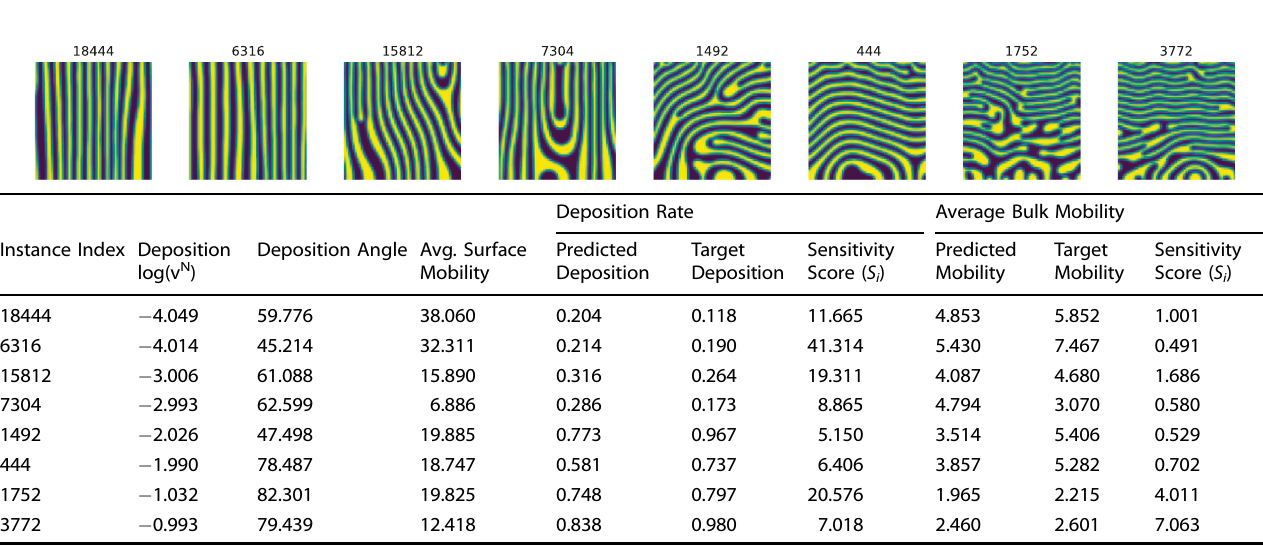
Table 2. Prediction of mobility parameters in the case of the physical vapor deposition